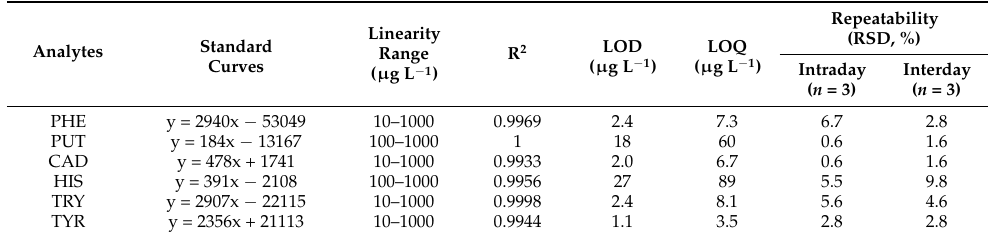
Table 1. The standard curves, linear range, LOD, LOQ, and repeatability of the SPME Arrow GC–MS method for the determination of six biogenic amines.